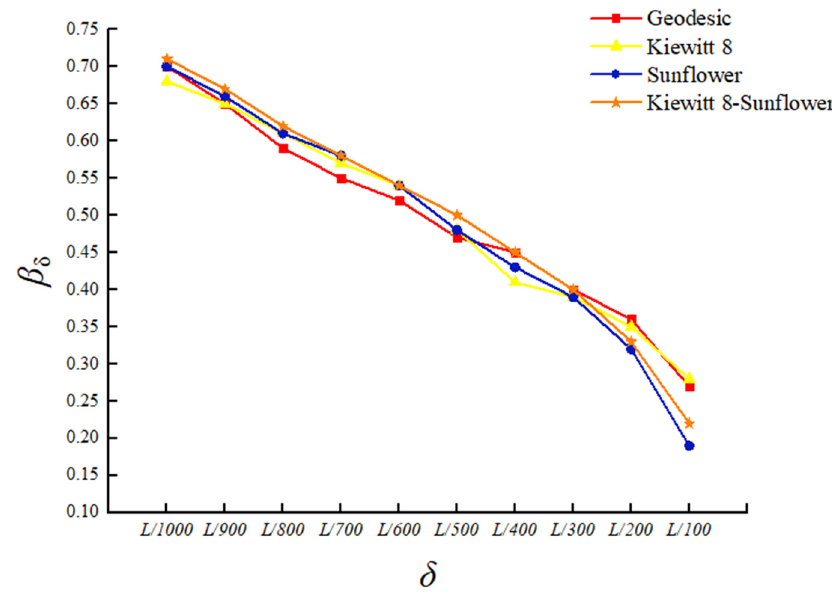
Figure 6. The relationship between defect factor ( β δ ) and IGDM( δ ).